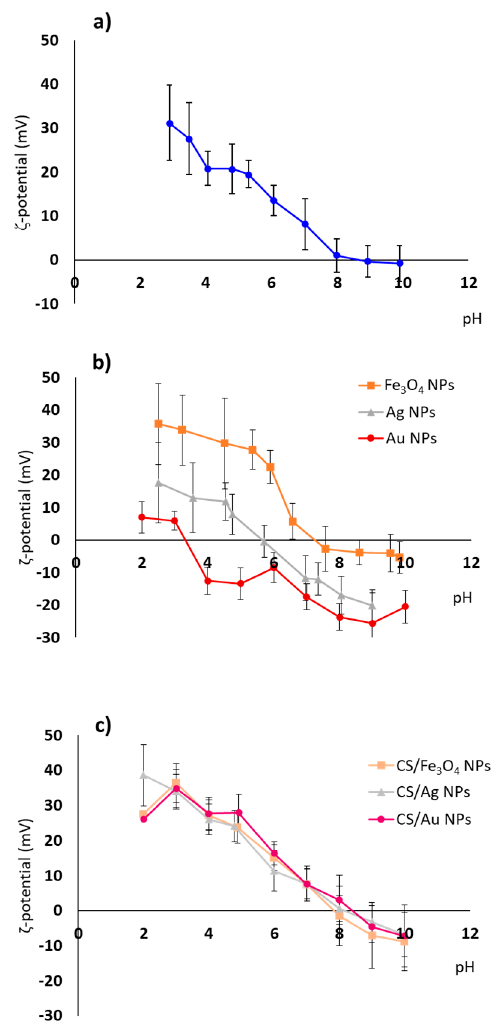
Figure 2. Surface ζ -Potential graphics of ( a ) CS NPs, ( b ) inorganic NPs and ( c ) hybrid CS-based NPs. The FTIR spectra of CS and hybrid CS based NPs were recorded (Figure 3). The spectra of the polymer (CS) and each inorganic NP are reported in Supplementary Materials.